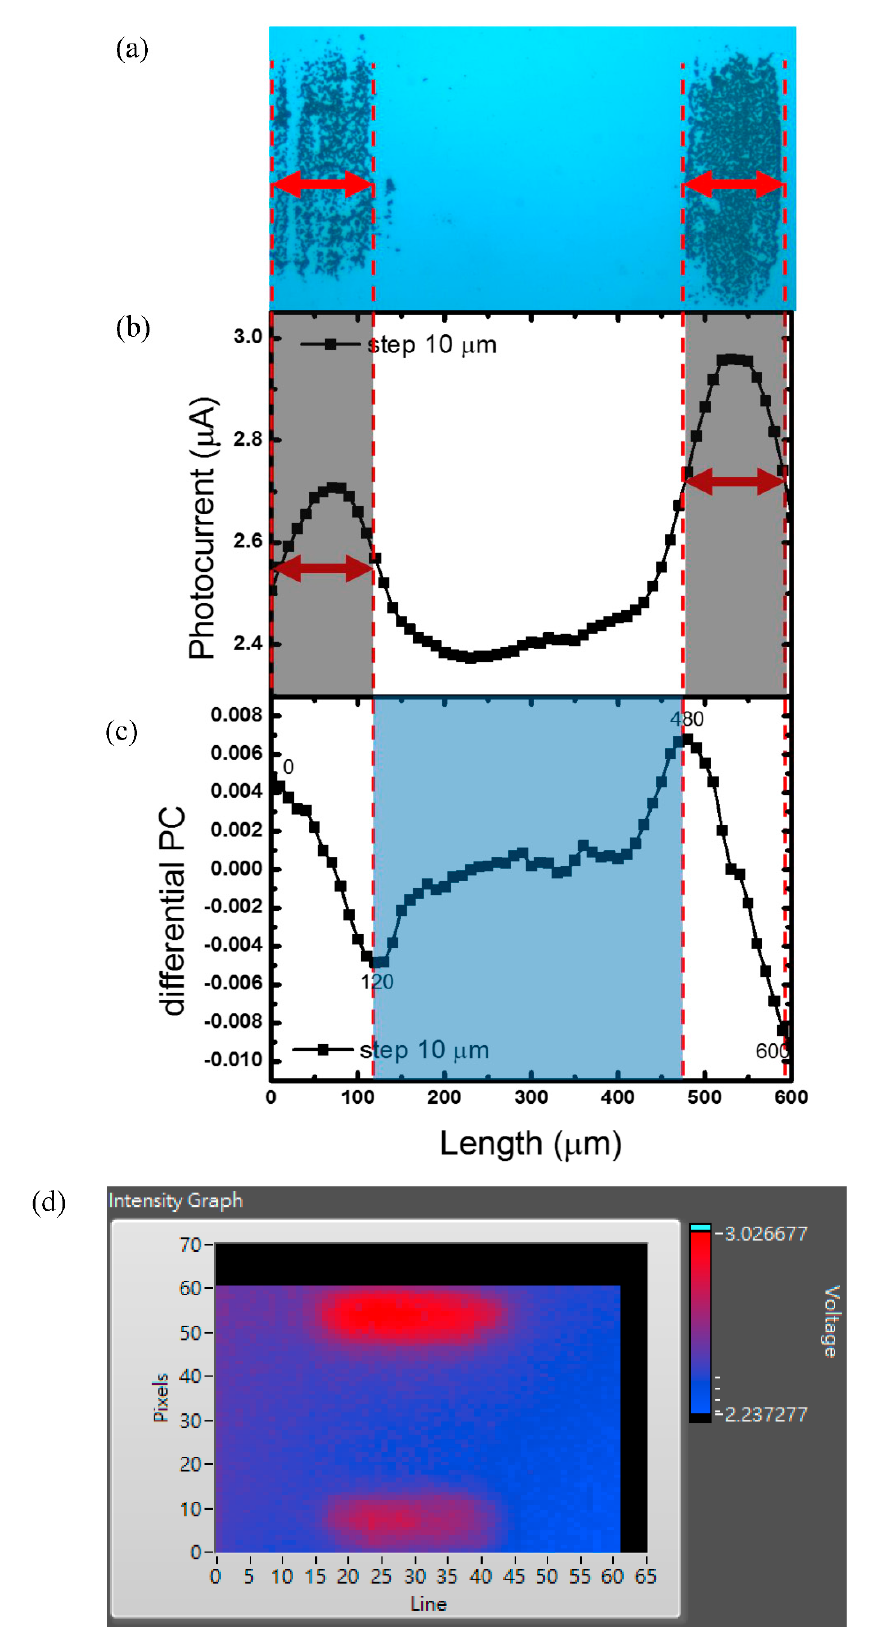
Figure 3. ( a ) OM picture of attached magnetic beads, ( b ) photocurrent versus X-coordination curve. Gray area could be referred to area with magnetic beads. ( c ) differentiated photocurrent versus X- coordination curve. Blue area could be referred to area without magnetic beads. ( d ) 2D images directly measured from selfdeveloped LabVIEW